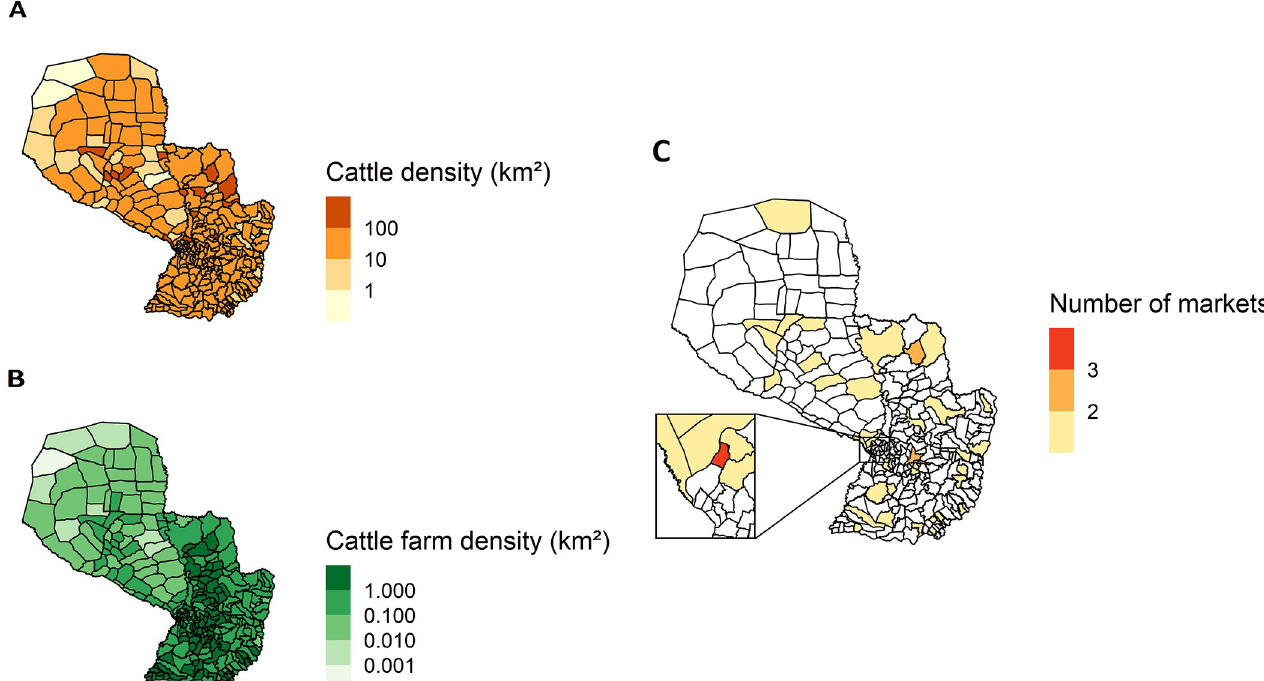
Fig 1. Density of cattle farms and cattle per km 2 and market location in Paraguay. Average annual number of farms and cattle from 2014 to 2018 were used. https://doi.org/10.1371/journal.pone.0278999.g001 Size and stability of networks Holding level. The global network was composed of 72,096 nodes and 366,626 links for all cattle, and 57,097 nodes and 126,359 links for only cows (Table 4) .